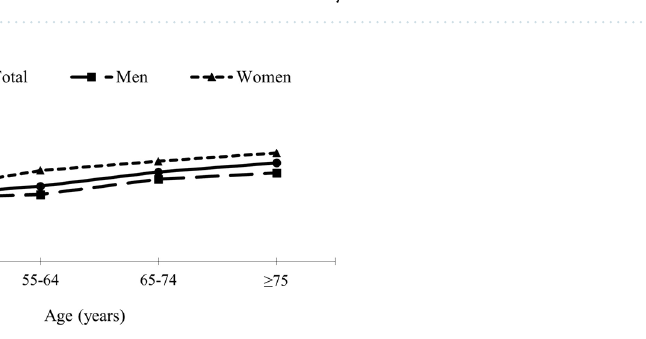
Figure 2. The age- and sex-specific prevalence (per 100 patients) of coronary heart disease in patients with acute ischemic